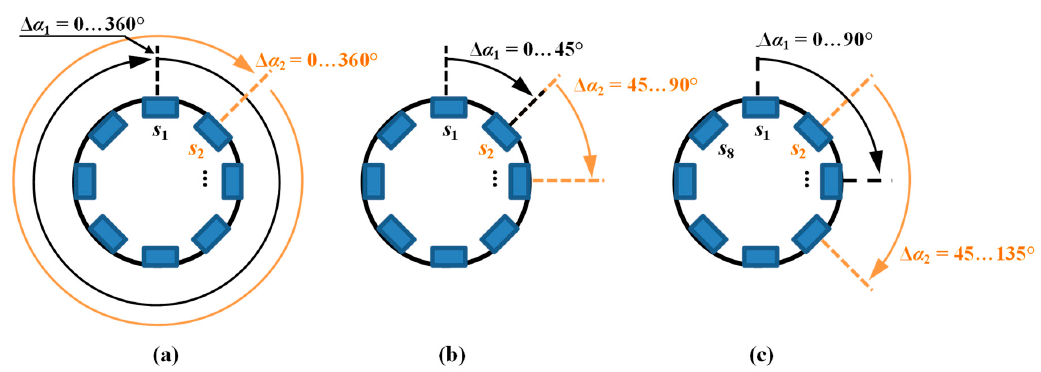
Figure 3. Presentation of implementation of various multisensor data fusion strategies: ( a ) competitive; ( b ) complementary; and ( c ) cooperative data.